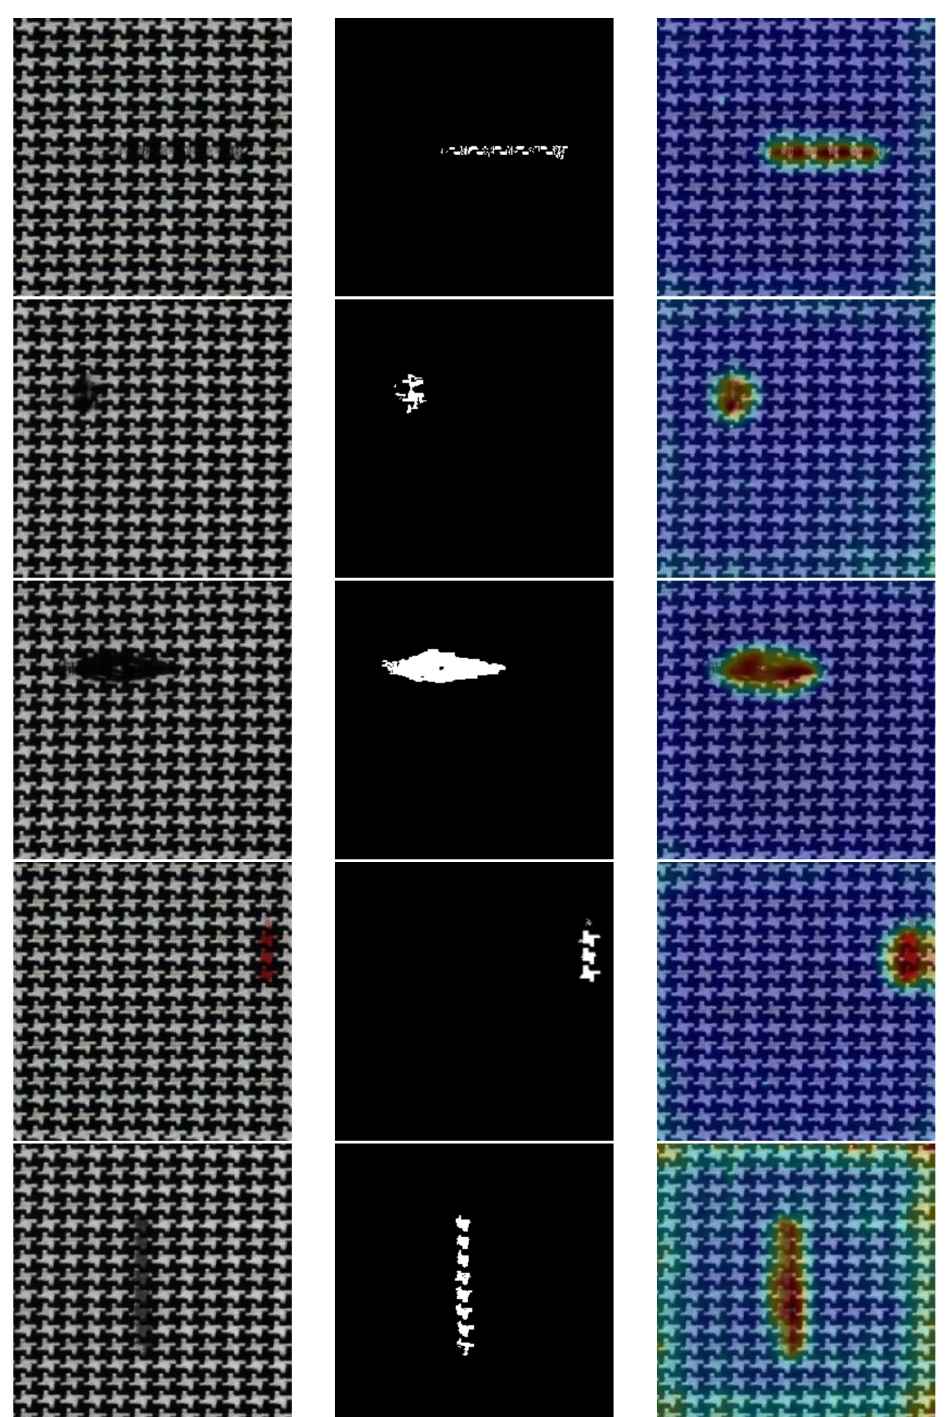
Figure 6. Inspection results of our proposed method on the star-patterned fabric dataset. The first row to the last row represent the broken-end, hole, netting-multiple, thick-bar, and thin-bar defects, respectively. The first column is the original image, the second column is the ground truth, and the third column is an anomaly